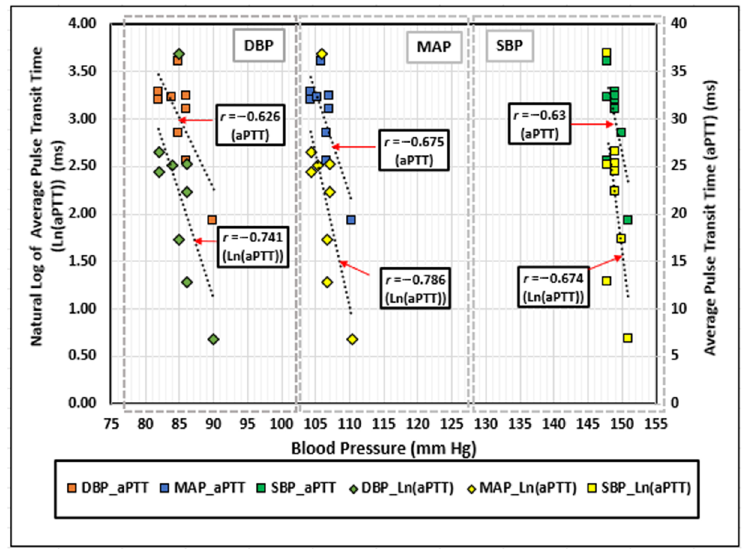
Figure 6. Plot of aPTT and Ln(aPTT) vs. BP where the ECG is extracted on the chest and the PPG on the wrist (test case 1 “TC ‐ 1”) (n = 8 trials).